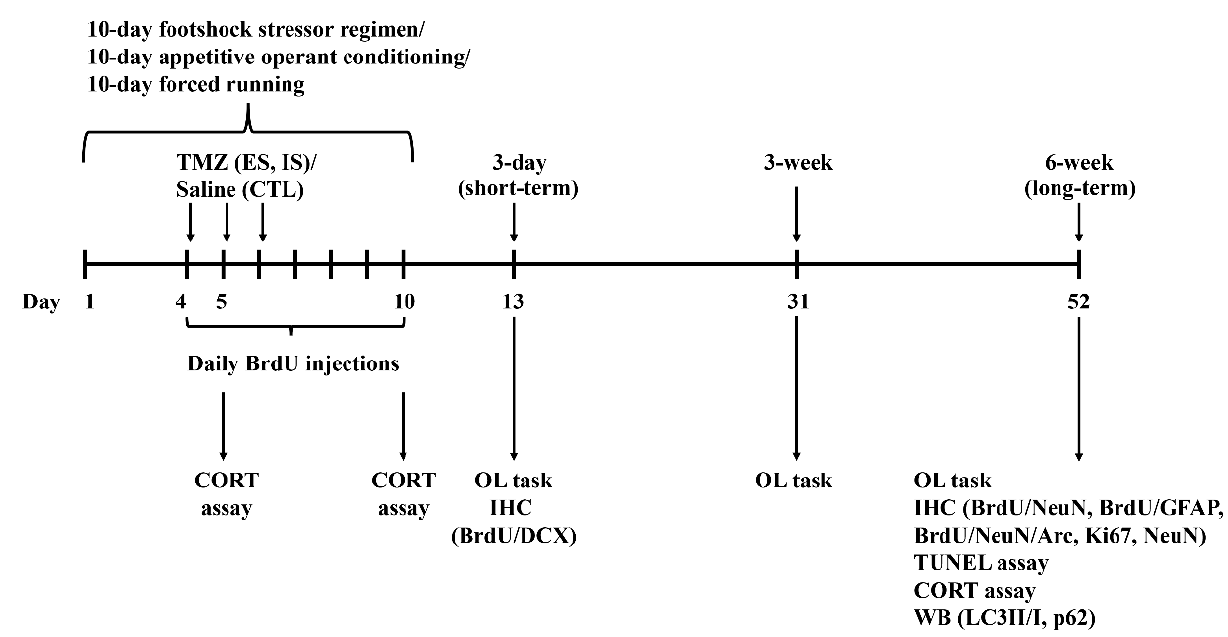
Figure 7. Experimental timelines for the 10-day regimens, biochemical assays, and behavioral tasks. Arc, BrdU, CORT, DCX, GFAP, IHC, NeuN, OL, TMZ, and WB are short forms of activity-regulated cytoskeleton-associated protein, bromodeoxyuridine, corticosterone, doublecortin, glial fibrillary acidic protein, immunohistochemistry, neuronal nuclei, object localization, temozolomide, Western immunoblotting, respectively.